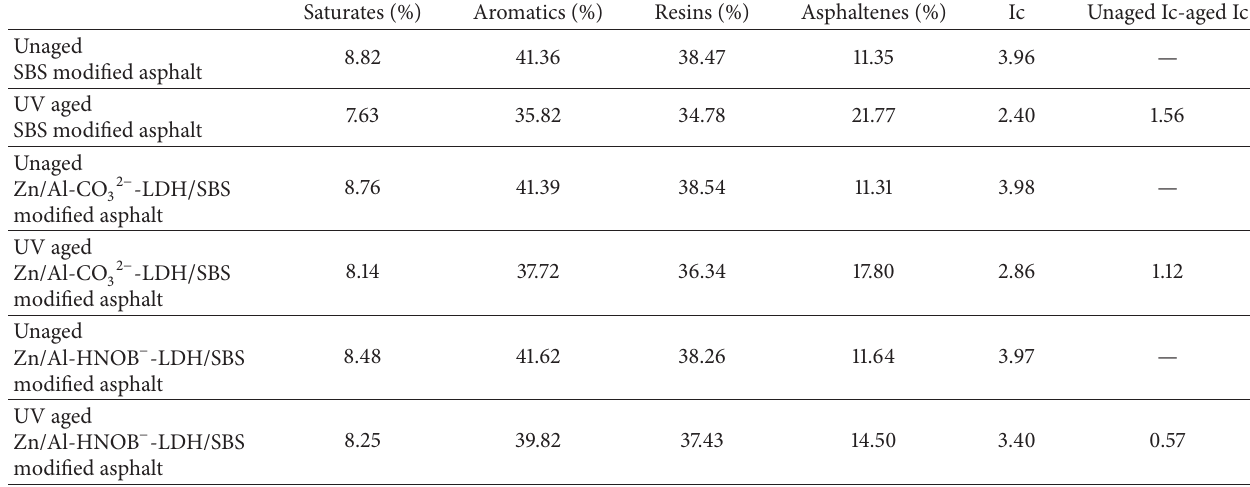
Table 2: Chemical compositions of asphalts before and after UV aging.